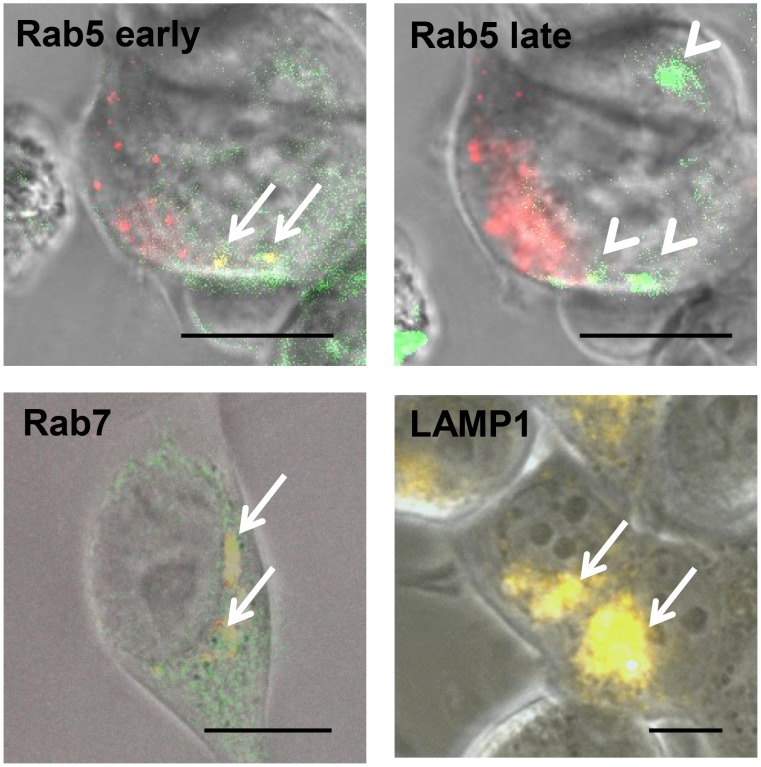
Uptake of TPP between 0 and 60 min follows an endosomal pathway.MCF7 cells take up CF-labeled TPP via an endosomal transport route in a time-dependent manner. Co-localization of TPP (green) with the endosomal marker proteins (Rab5, Rab7, LAMP1; each in red) is visible as a yellow signal. Co-localization of TPP with Rab5 can be seen within early endosomes at early time points (<30 min, arrows, upper left graph), but not at later time points (arrow heads, upper right graph). Between 30 and 60 min, TPP co-localizes with Rab7 vesicles (arrows, lower left graph). After 60 min, TPP co-localizes with LAMP1 positive lysosomes (arrows, lower right graph). Images are representative three-channel composites: brightfield, FITC, RFP. Objective 63×; scale bar 10 µm.